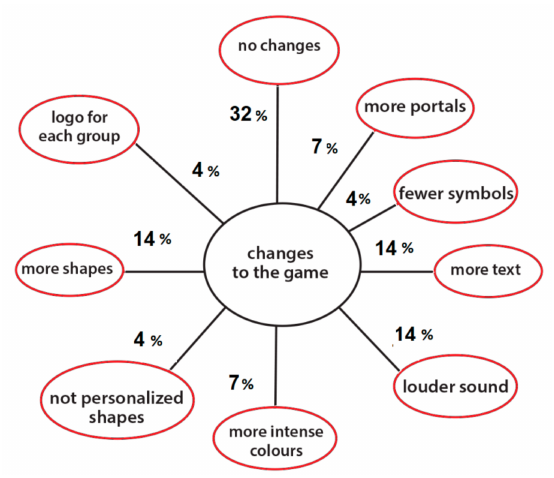
Figure 5. Subthemes with percentages of mentions related to the main thematic “changes to the game” (question 5). Subthemes in red relate to the